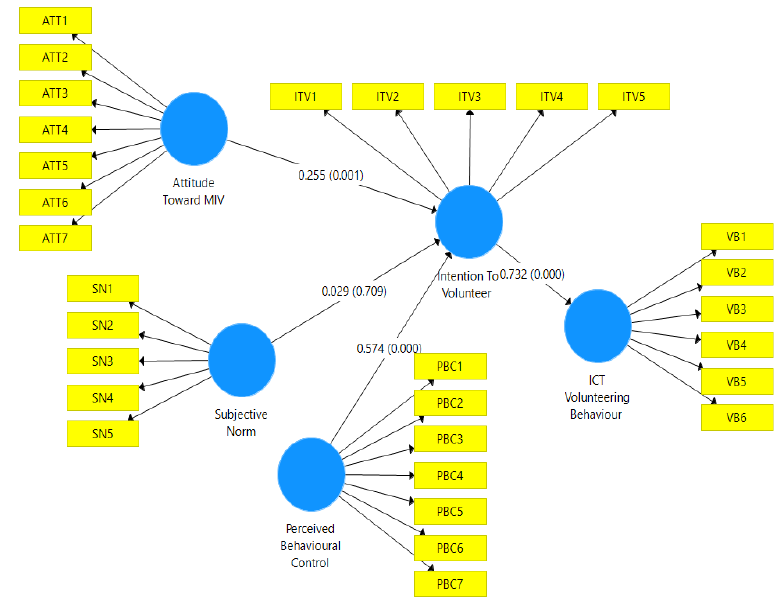
Figure 3. The structural model for MIV